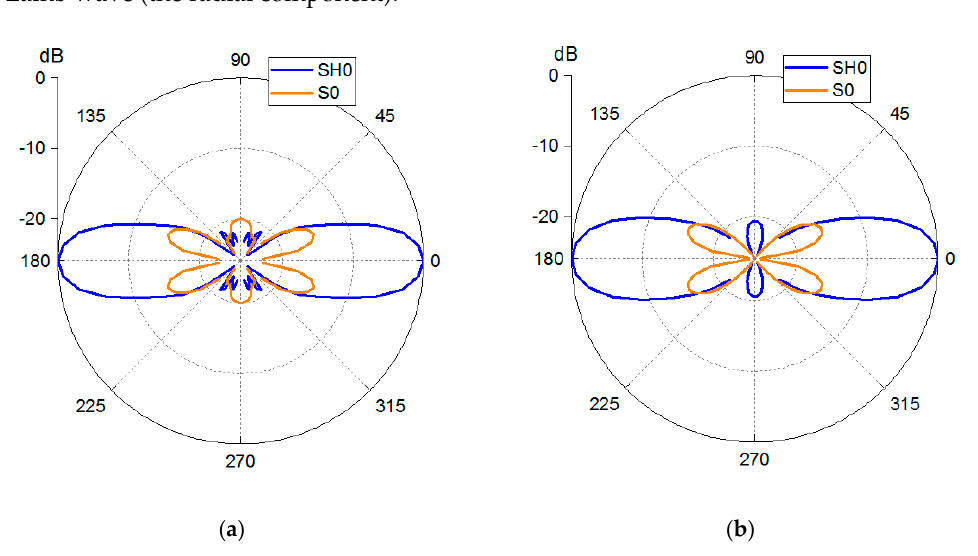
Figure 13. A normalized polar diagram of the wave amplitude (particle velocity) of ( a ) the rounded- corner SHPFP and ( b ) the SHPFP. The blue lines show the SH0 wave amplitude, while the orange lines show the unwanted S0 Lamb wave amplitude.